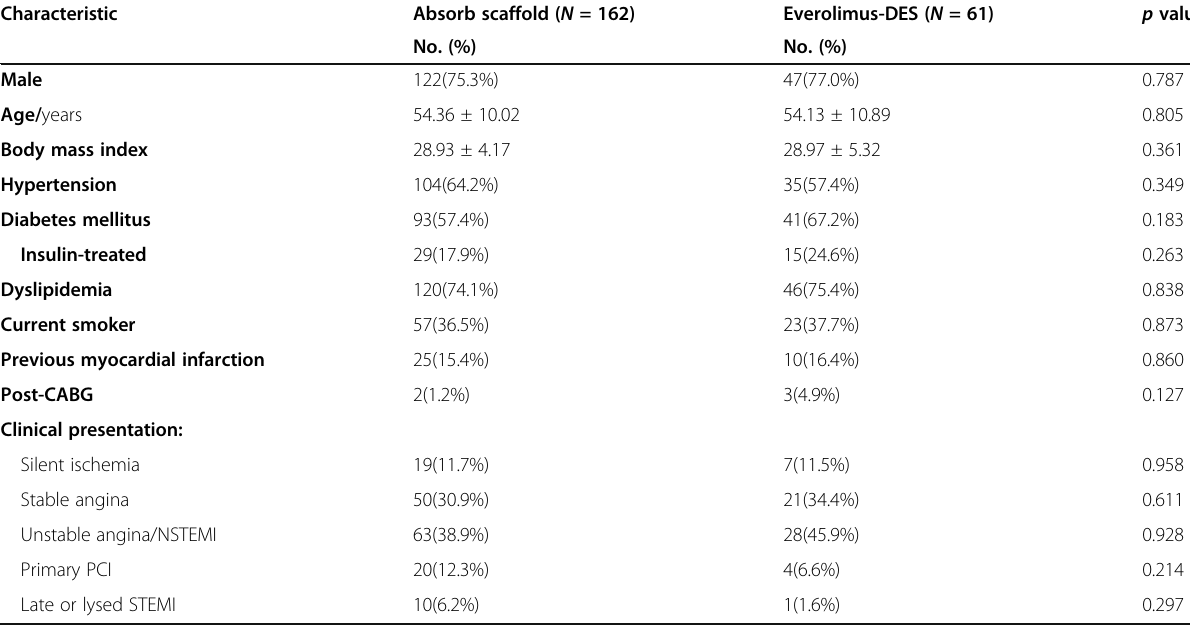
Table 1 Baseline demographics and clinical characteristics Characteristic Absorb scaffold ( N =